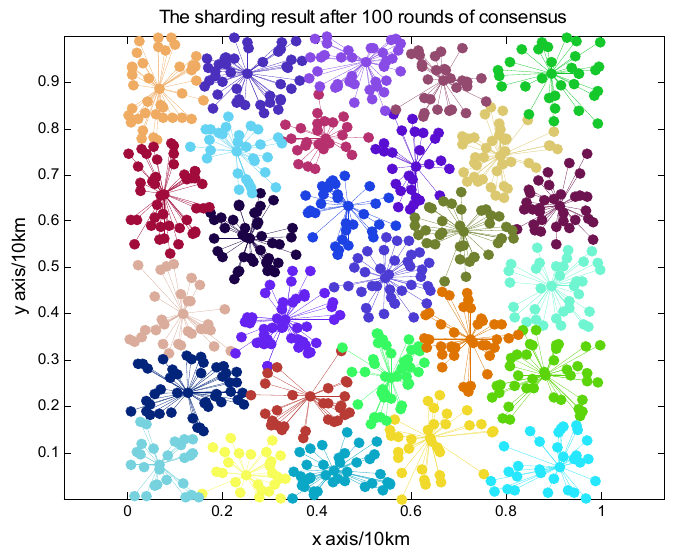
Figure 11. The clustering results after 100 rounds of consensus.